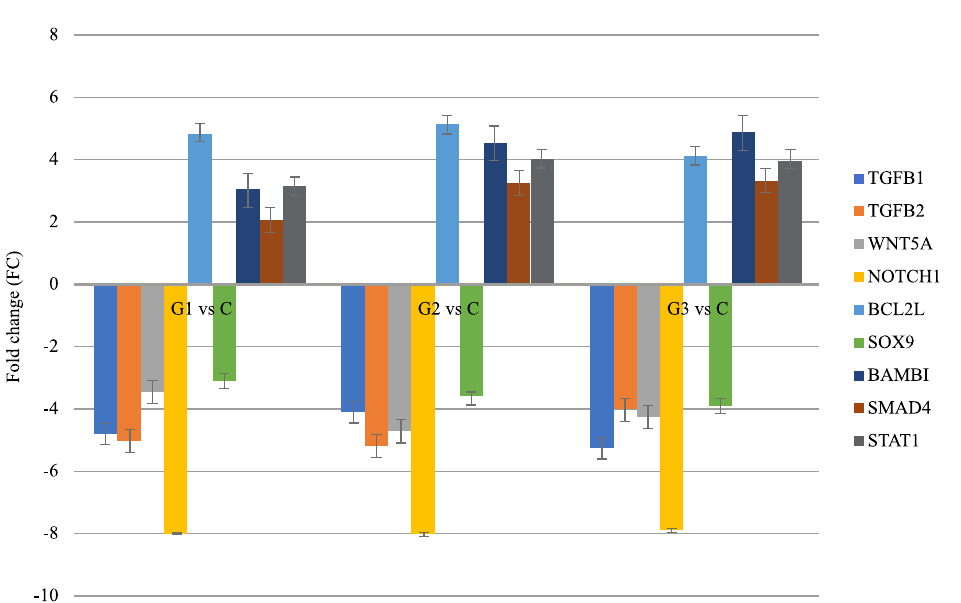
Figure 2. Expression pattern of genes related to EMT, which differentiates in patients with endometrial cancer (tissue, whole blood), compared to a control group.